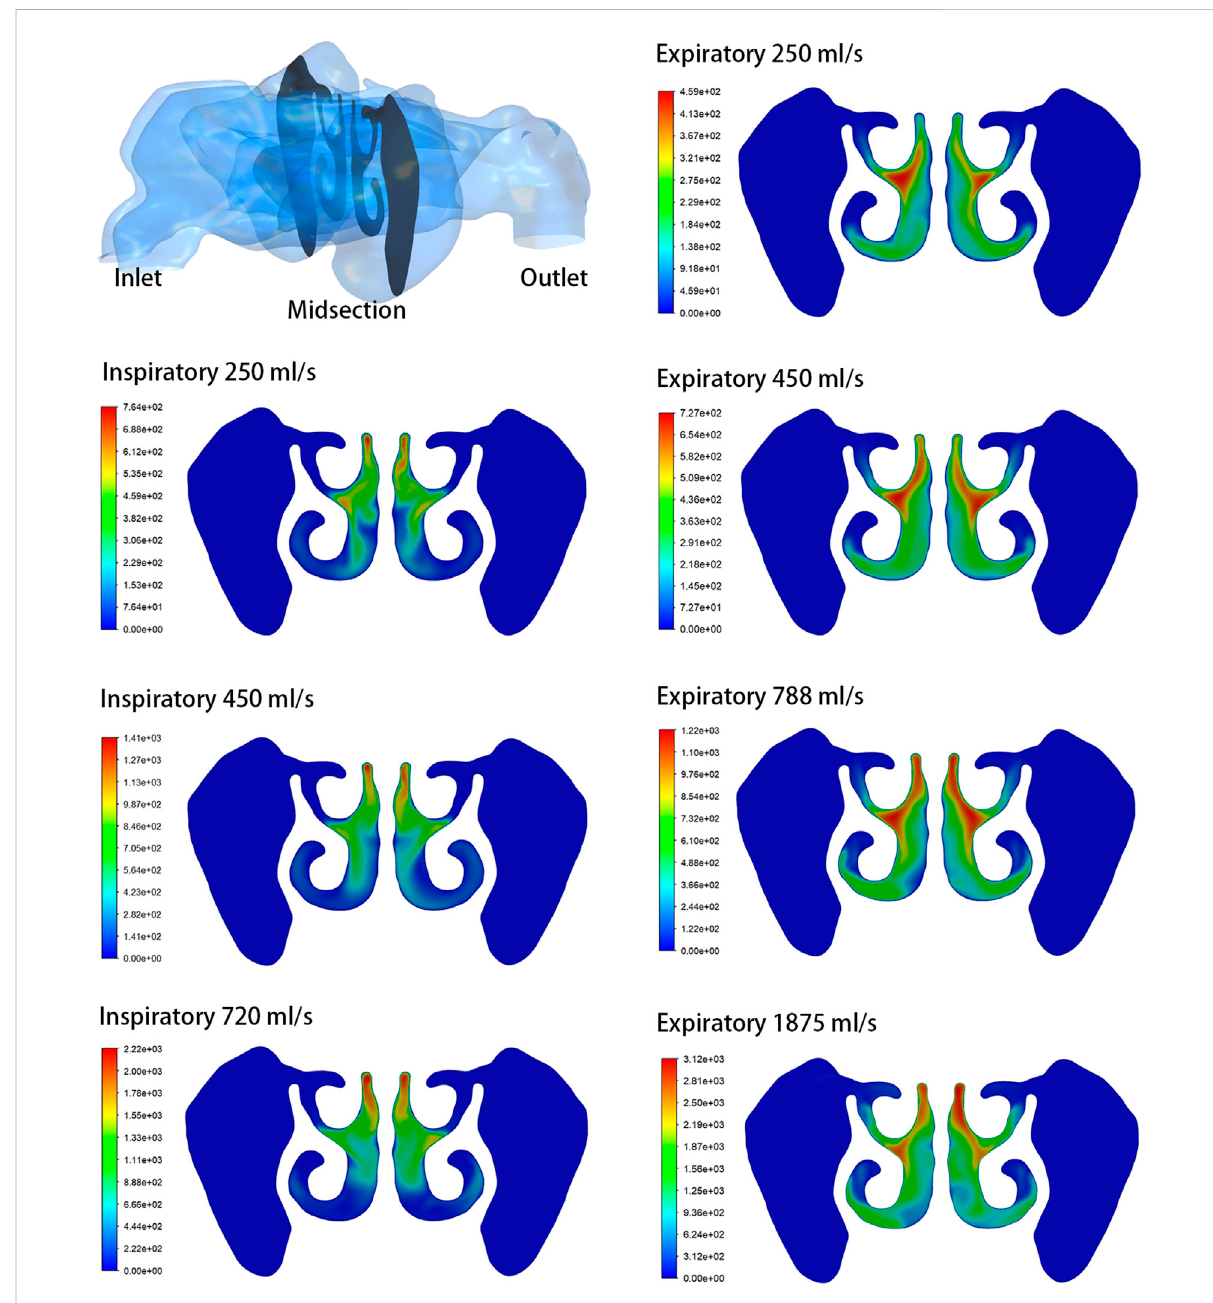
FIGURE 5 Contours of Reynolds number at the middle coronal section under different inlet fl ow